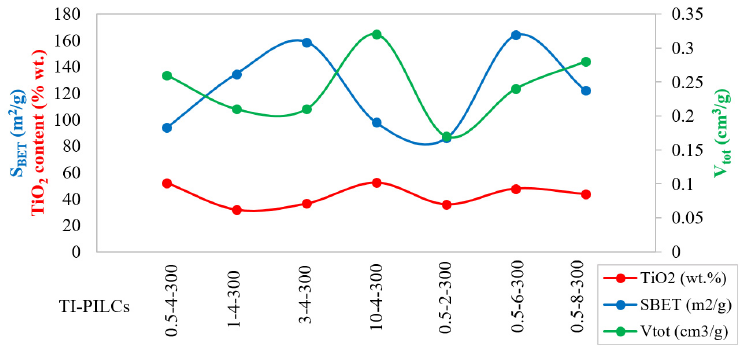
Figure 13. The relationship between the TiO 2 content of Ti-PILCs and their porous properties.